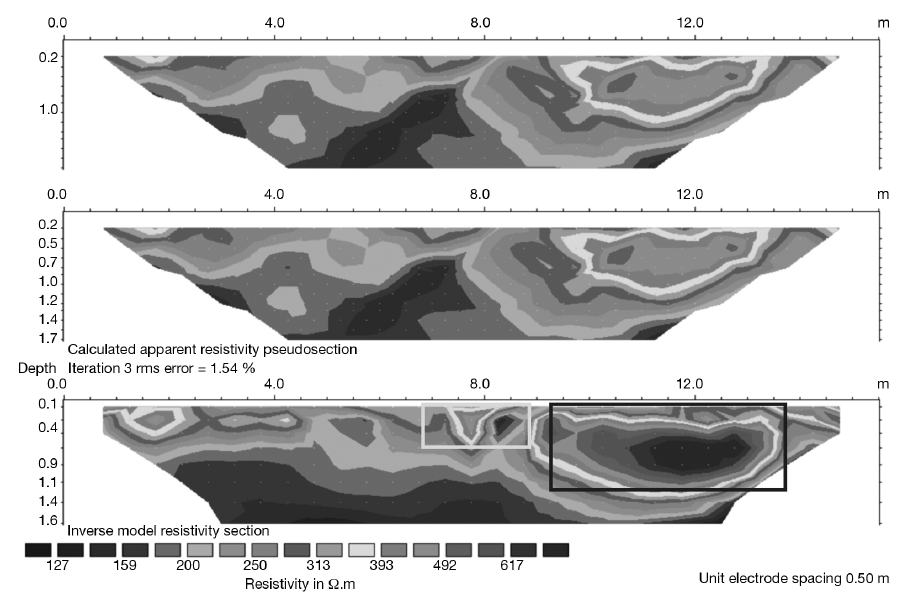
Fig. 7. Geoelectric multi-electrode dipole-dipole profile. Dotted line box identifies anomaly due to a wall struc- ture. The white box shows the anomaly linked to the